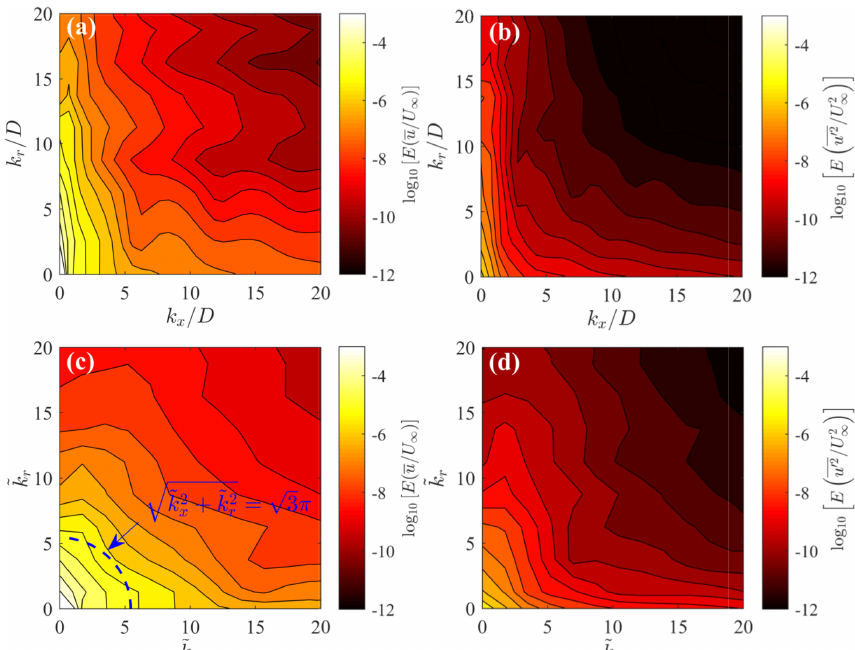
Figure 9. Azimuthally averaged energy spectra of the LES velocity fields. (a) Mean streamwise velocity on the physical domain, (b) variance of streamwise velocity on the physical domain, (c) mean streamwise velocity on the scaled domain, and (d) variance of streamwise velocity on the scaled domain. The blue dashed line indicates wavenumbers reconstructed with response equal to D m ( (cid:49) ˜ n 0 ) = 0 .